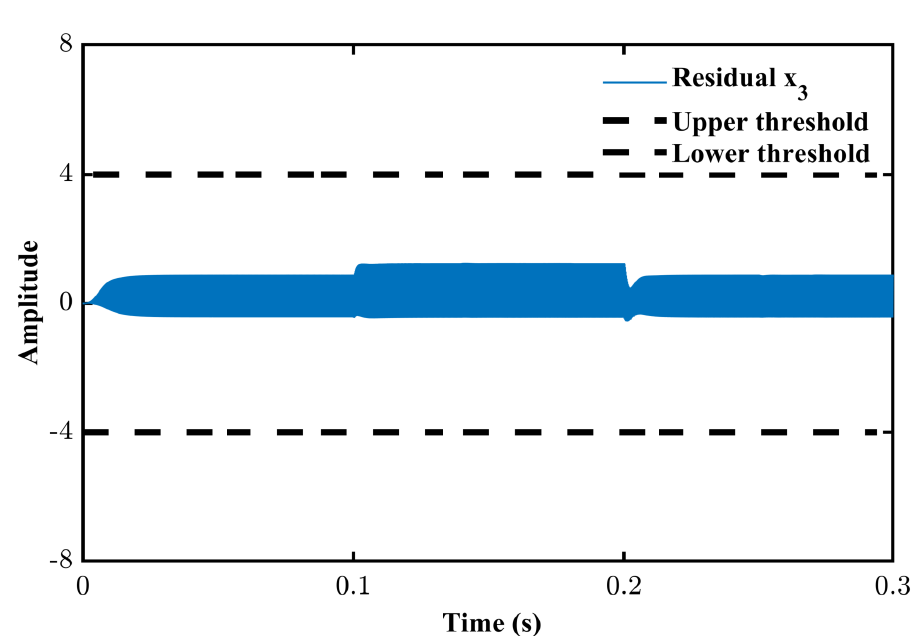
Figure 13. Residual formation of sensor x 3 .